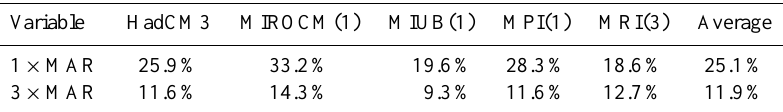
Table 8. Relative within-GCM uncertainty of reservoir yield for hypothetical reservoirs of 1 × and 3 × MAR. The average of 17 catchment relative uncertainty values is presented. Relative uncertainty is the standard deviation of the 100 replicate estimates as a percentage of the mean replicate estimate for each GCM over the period 2015–2044